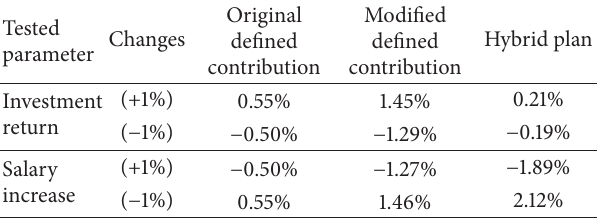
Table 9: Results of sensitivity analysis (replacement